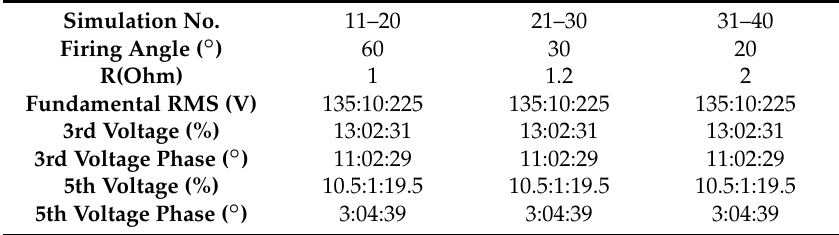
Table 5. Changing experimental parameters and harmonic voltage components in simulations.